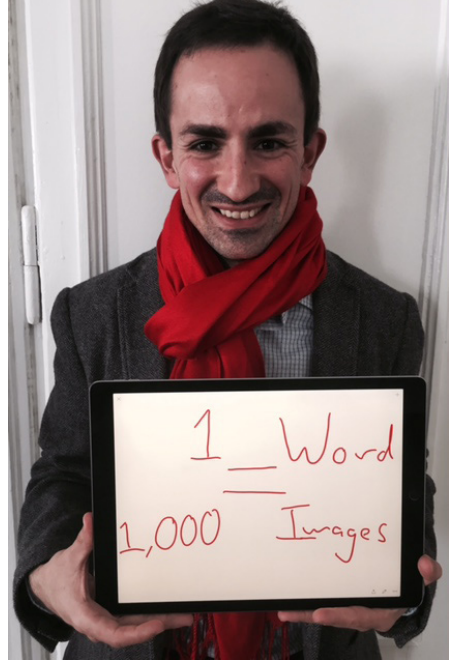
Figure 5. Second and final stages: writing the sign digitally/taking the